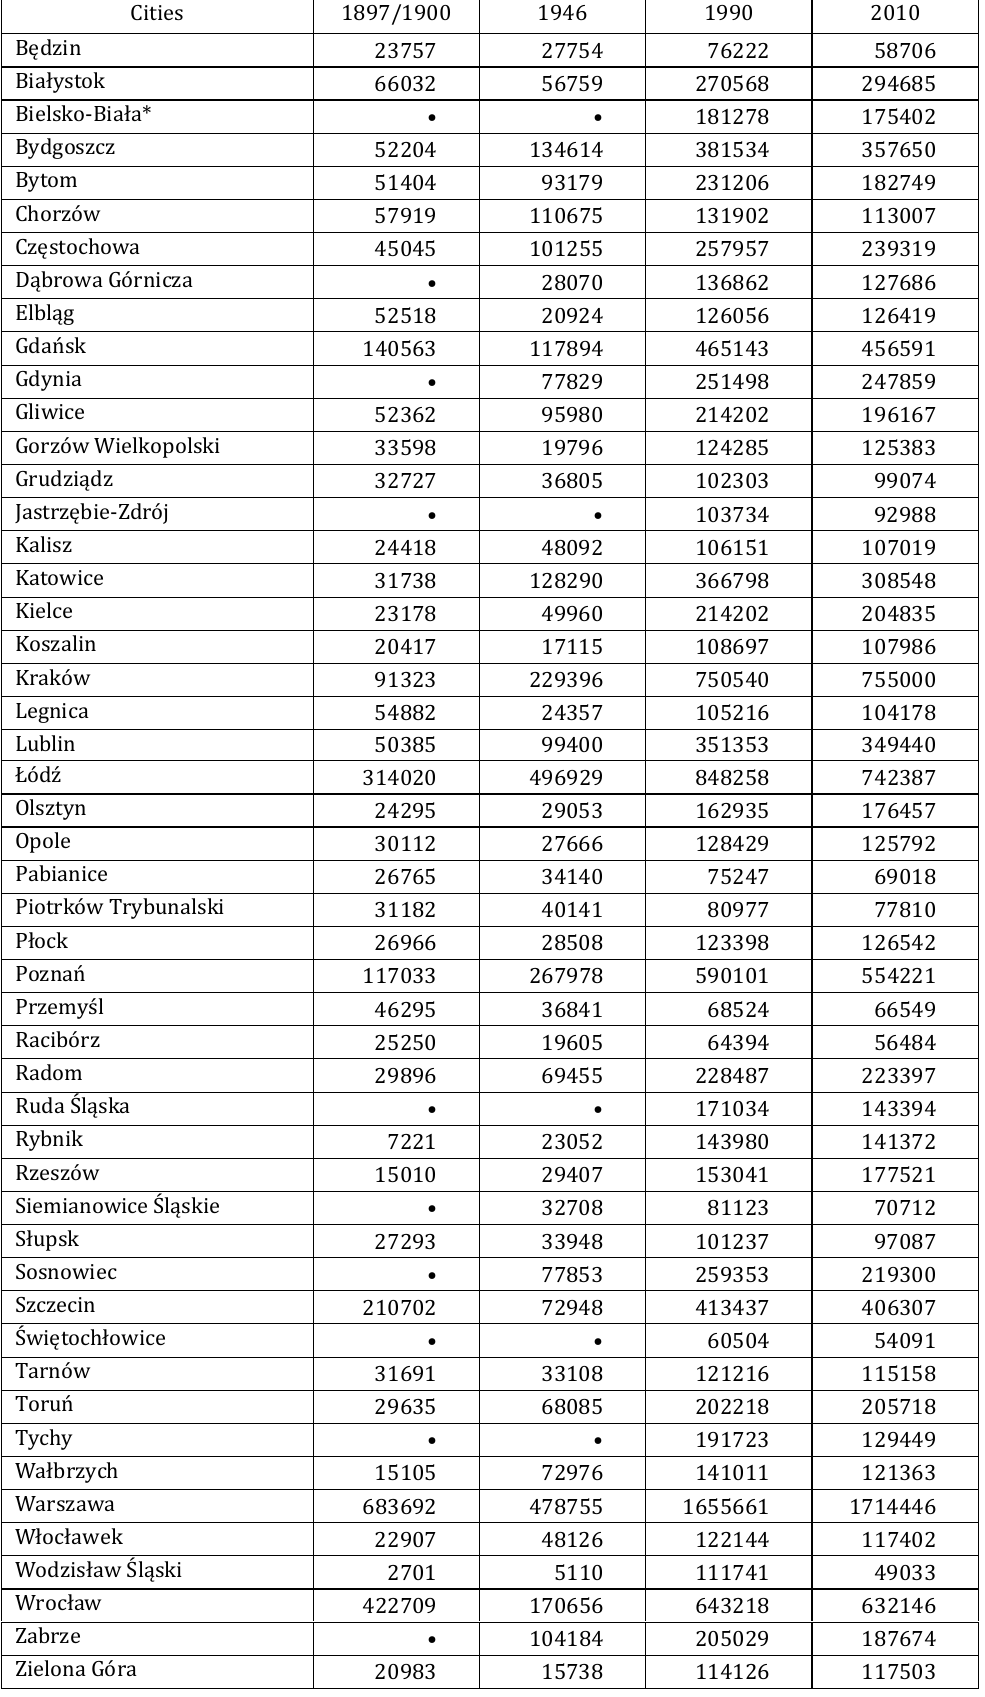
Table 1. Population changes in studied cities of